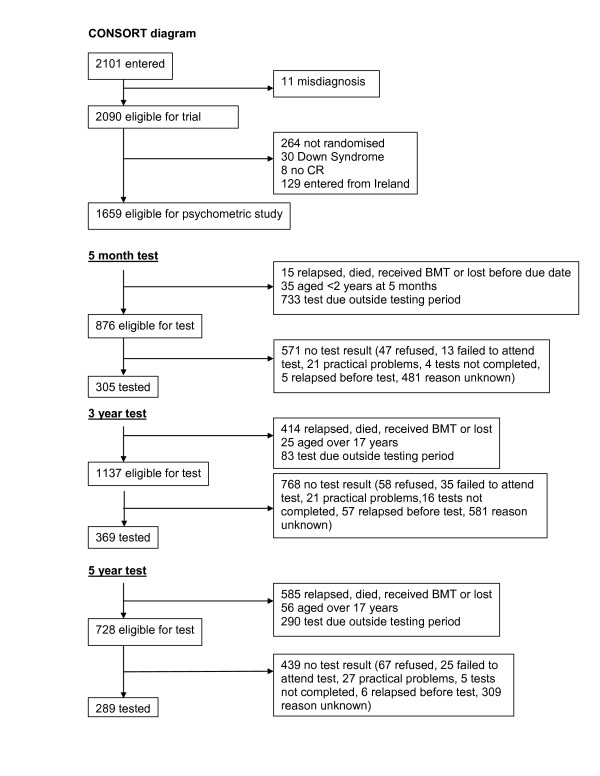
CONSORT Diagram.